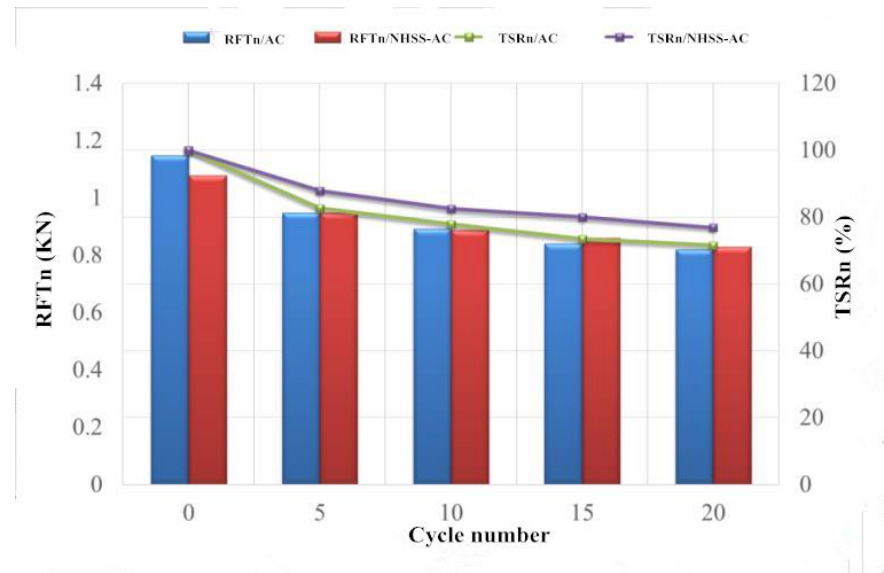
Figure 9. TSRn changes of mixtures under freeze – soak – scour cycles.